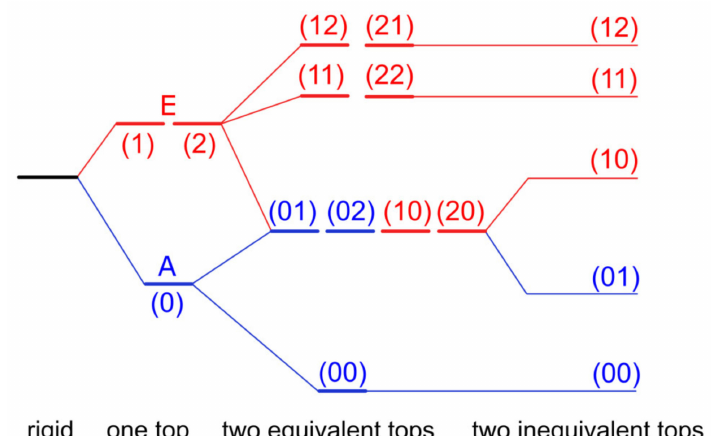
Figure 1. Schematic energy-level diagram illustrating the splittings caused by internal rotation for (i) a rigid rotor (no torsional splitting), (ii) a molecule containing one methyl rotor (splitting into an A and a doubly degenerate E torsional-symmetry species), (iii) a molecule containing two equivalent methyl rotors (splitting into four torsional species), and (iv) a molecule containing two inequivalent methyl rotors (splitting into five torsional species). The three torsional states of the methyl top are given as σ = 0, 1, 2 [28]. The (11) and (12) species are not degenerate due to top–top